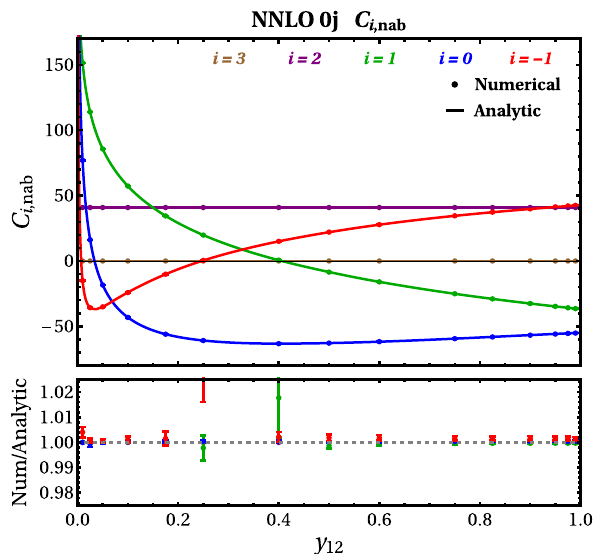
Fig. 3 Numericalresultsforthenon-Abelianpartofthe0-jettinesssoft function at NNLO for the partonic channel q ¯ q . We plot the coefficients of δ( T 0 ) and L n ( T 0 ) with n = 0 , 3 as functions of y 12 ∈ [ 0 , 1 ] . The analytic results are taken from Ref.